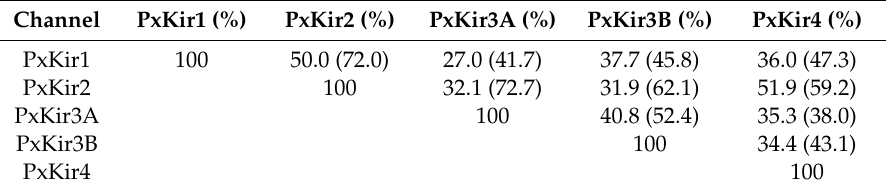
Table 3. Amino acid sequence similarity between Plutella xylostella Kir